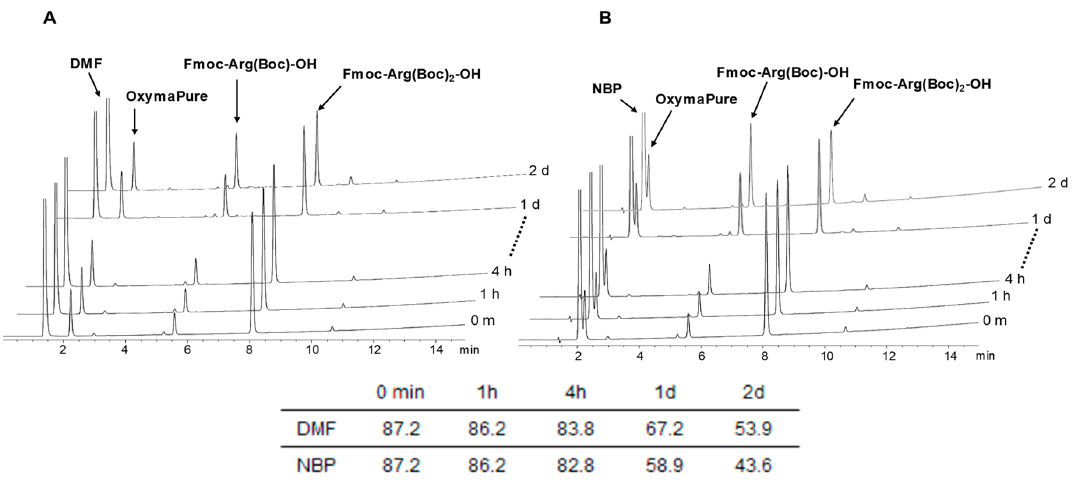
Figure 2. Stability of the mixture of Fmoc-Arg(Boc) 2 -OH/OxymaPure 1:1 in DMF (A) and NBP (B) at 45 °C. Elution: 30-95% of B into A in 15 min.